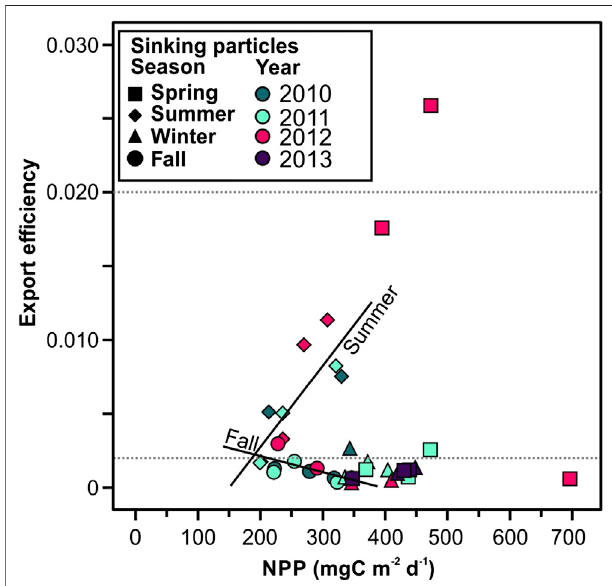
FIGURE 10 | Net primary productivity (NPP) plotted against export ef fi ciency (POC fl ux/NPP). Horizontal dashed lines indicate threshold for export ef fi ciency regimes: high export ef fi ciency is de fi ned as > 0.2 (eightieth percentile of data), low export ef fi ciency is < 0.02 (twentieth percentile), and moderate export ef fi ciency lies between. Signi fi cative regression lines are shown for summer (Export ef fi ciency (cid:2) 0.00006NPP – 0.0082, r (cid:2) 0.824, p < 0.05), and fall (Export ef fi ciency (cid:2) − 0.00001NPP+0.0043, r (cid:2) 0.661, p (cid:2)